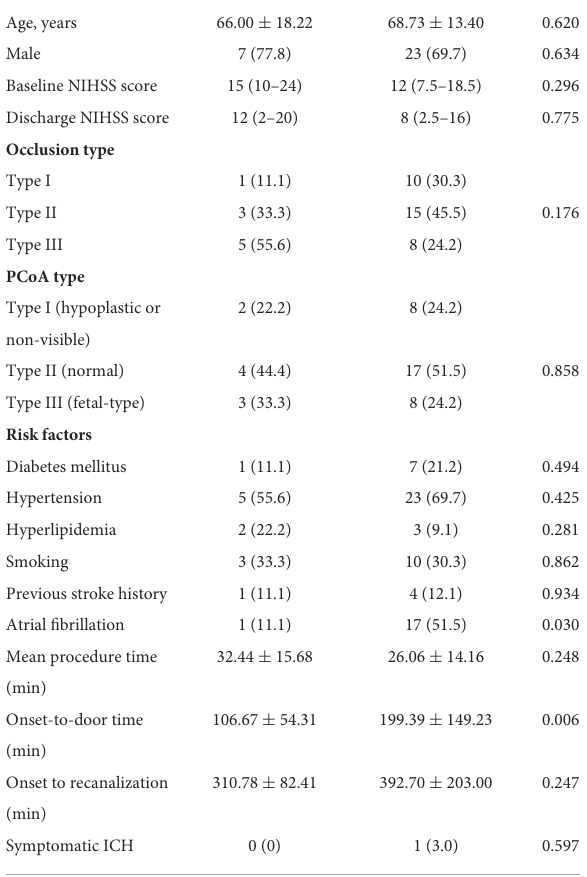
TABLE 4 Comparison of baseline characteristics in those with and without successful recanalization (TICI